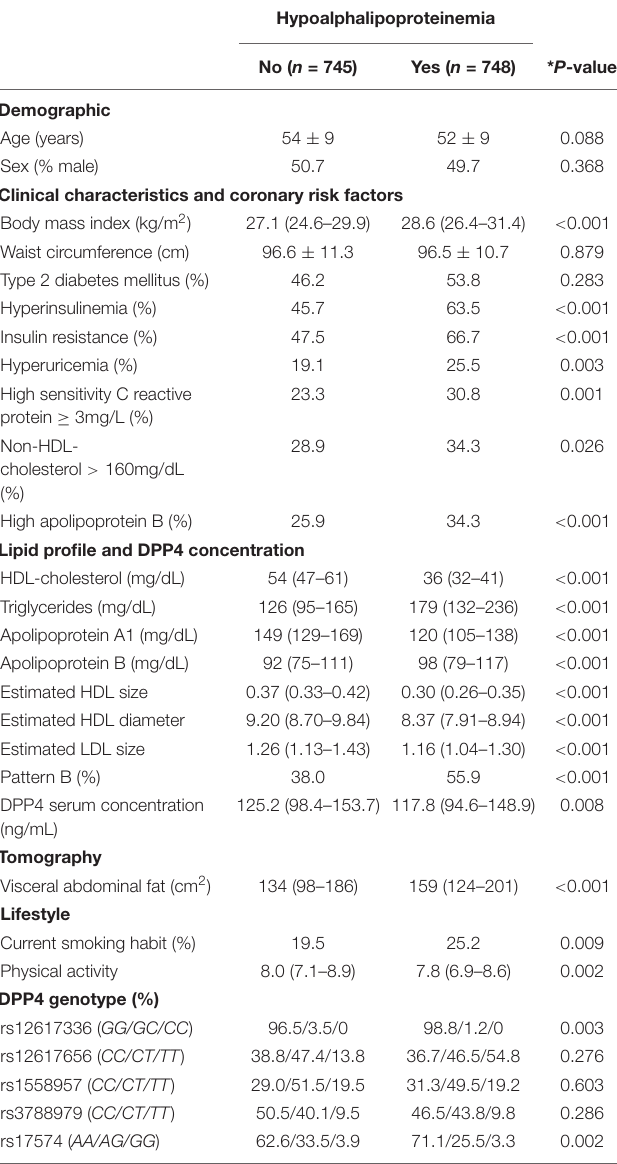
TABLE 1 | Demographic, lifestyle, clinical characteristics, lipid profile, tomographic data, and genotypes in the studied